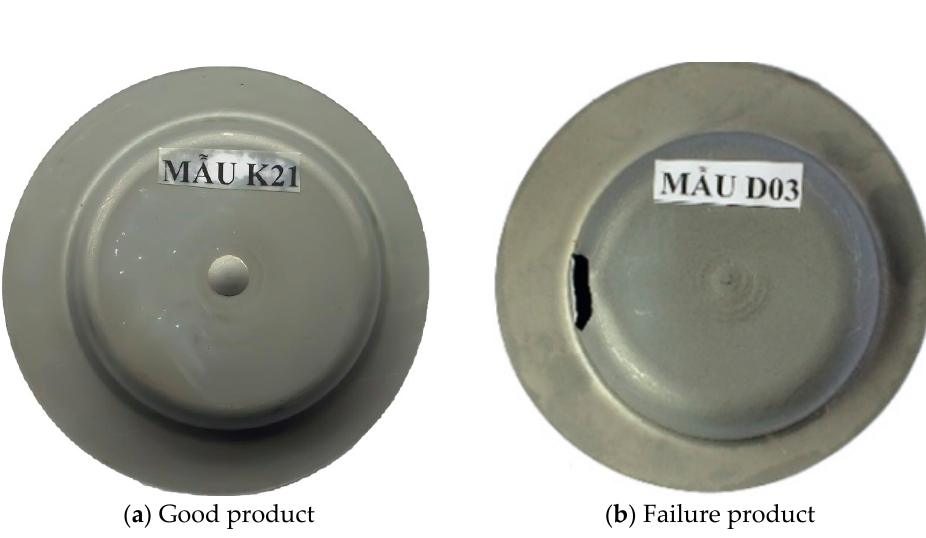
Figure 8. Experimental products.